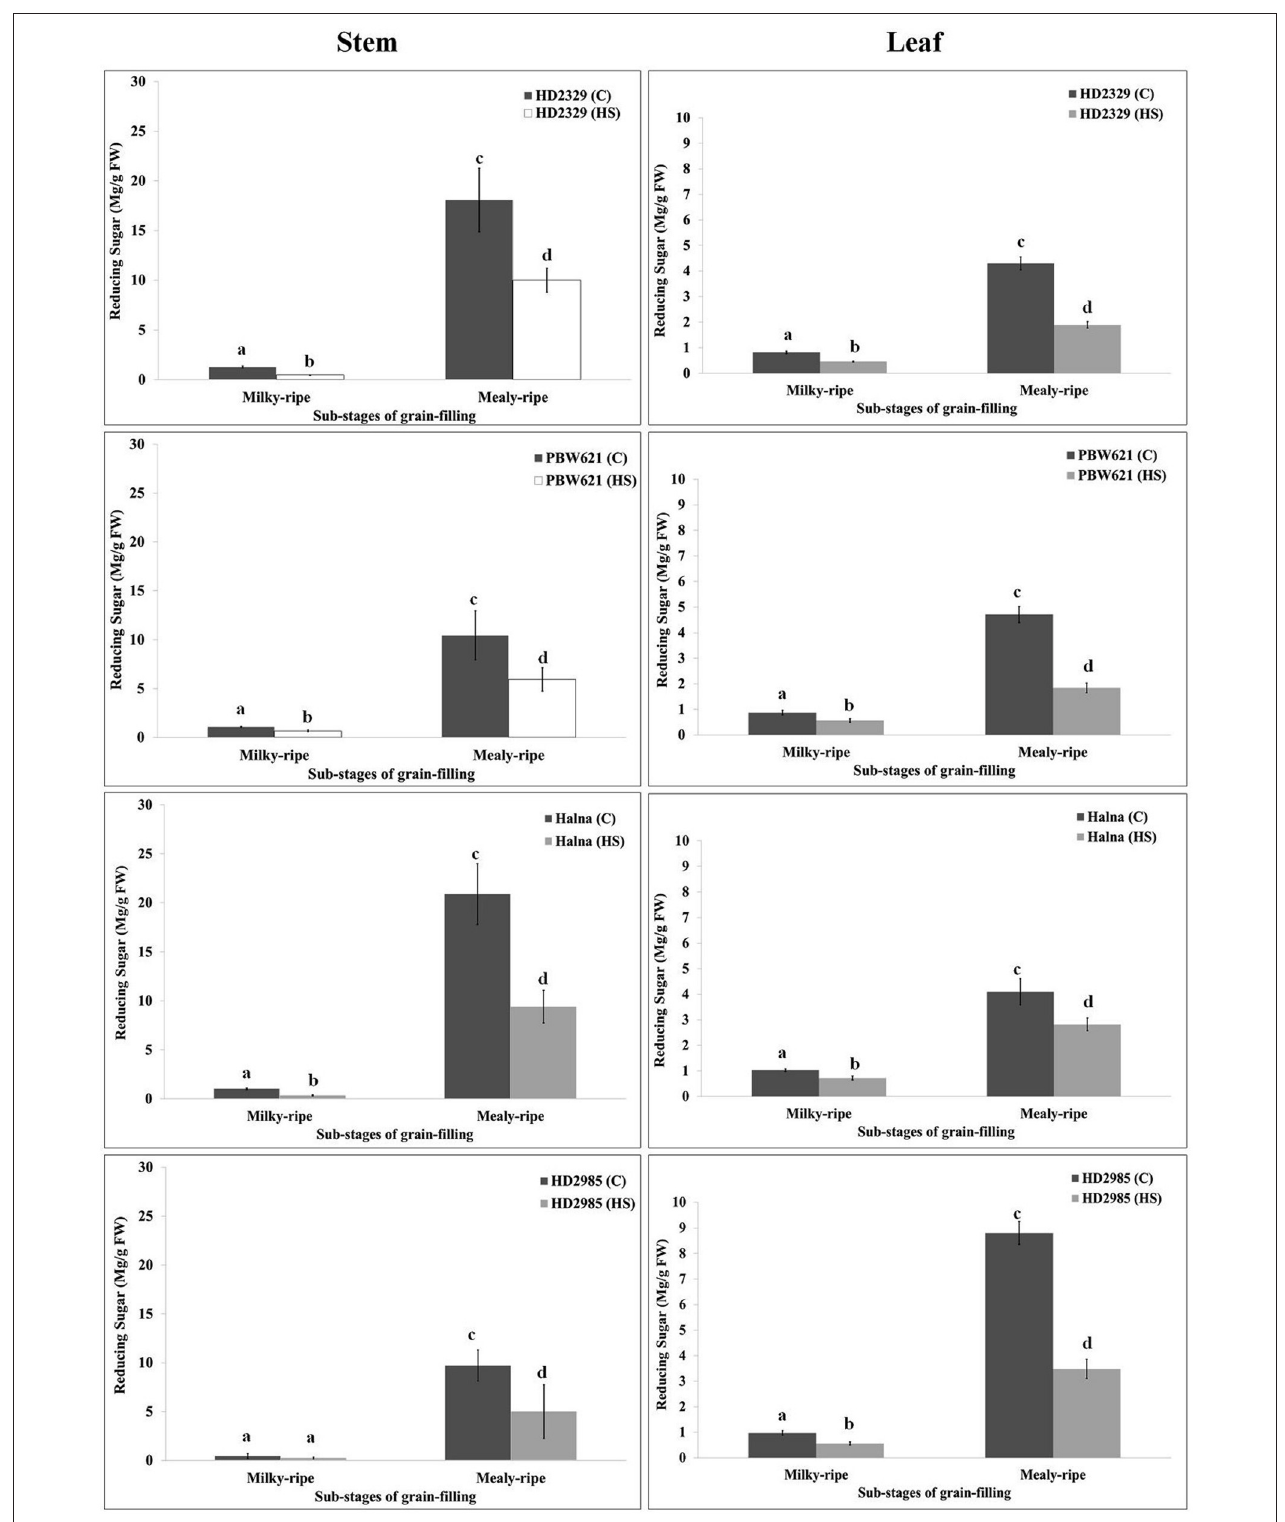
FIGURE 9 | Variations in the reducing sugar content in stem and leaves of contrasting wheat cvs . under control and heat stress conditions. HD2329, PBW621, Halna, and HD2985 were used for the reducing sugar pattern profiling; C − 22 ± 3 ◦ , heat stress − 42 ◦ C for 2 h; Milky-ripe and mealy-ripe sub-stages of grain-filling were used for the analysis; different letters above each bar indicate a significant difference ( p < 0.05 ) between the treatments (one-way ANOVA); vertical bars indicate SE ( n = 3 ).